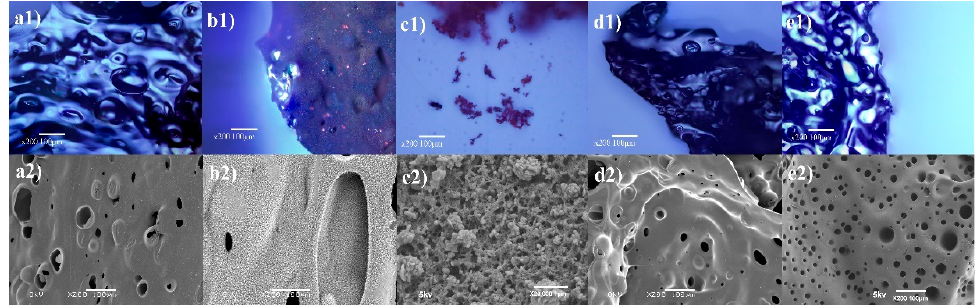
Figure 6. Optical microscope and SEM images of char residue of ( a1 , a2 ) PET, ( b1 , b2 ) MIL − PET, ( c1 , c2 ) crimson floccules in char residue, ( d1 , d2 ) P − PET, ( e1 , e2 ) MIL − P − PET.